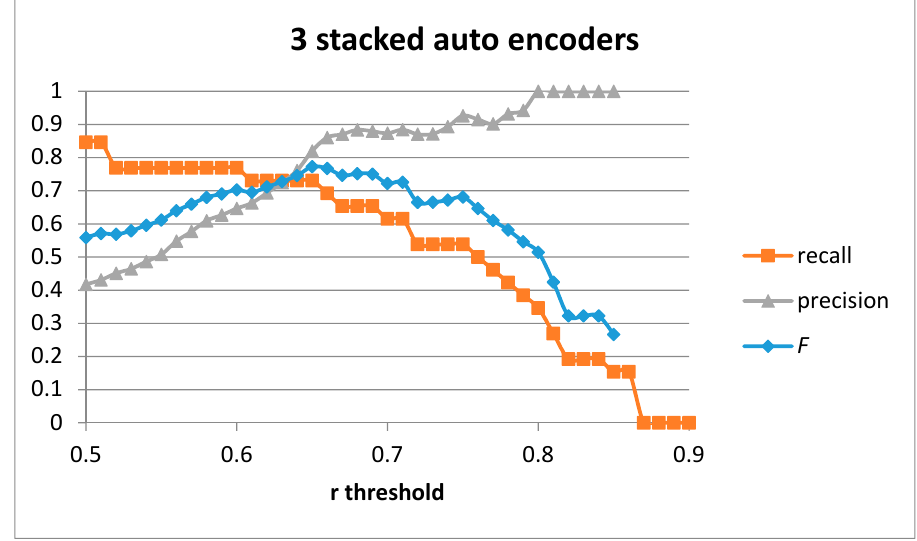
Figure 13. Precision, recall, and F score for three stacked auto-encoders and 100-75-50 hidden units. Table 12. Classification results for three layers of auto-encoders and recall 0.615.